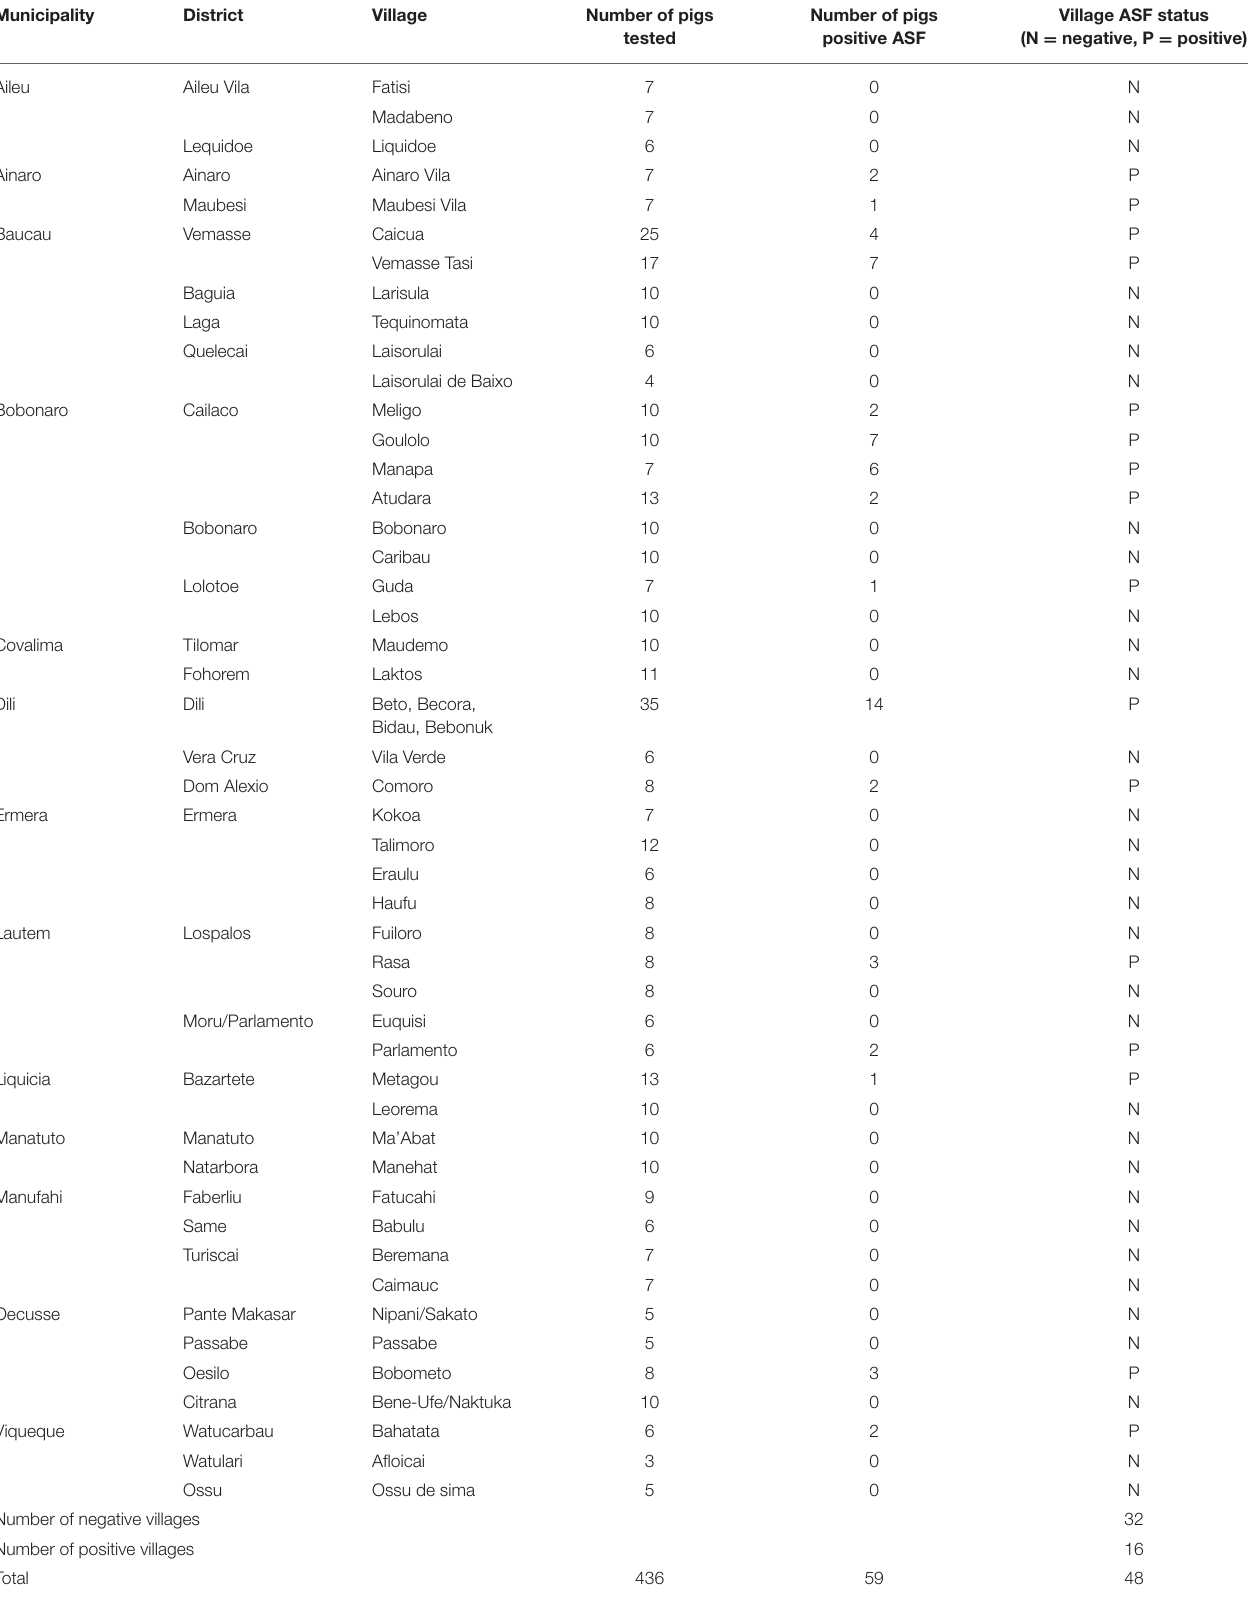
Number of pigs Village ASF status tested positive ASF (N = negative, P = positive)